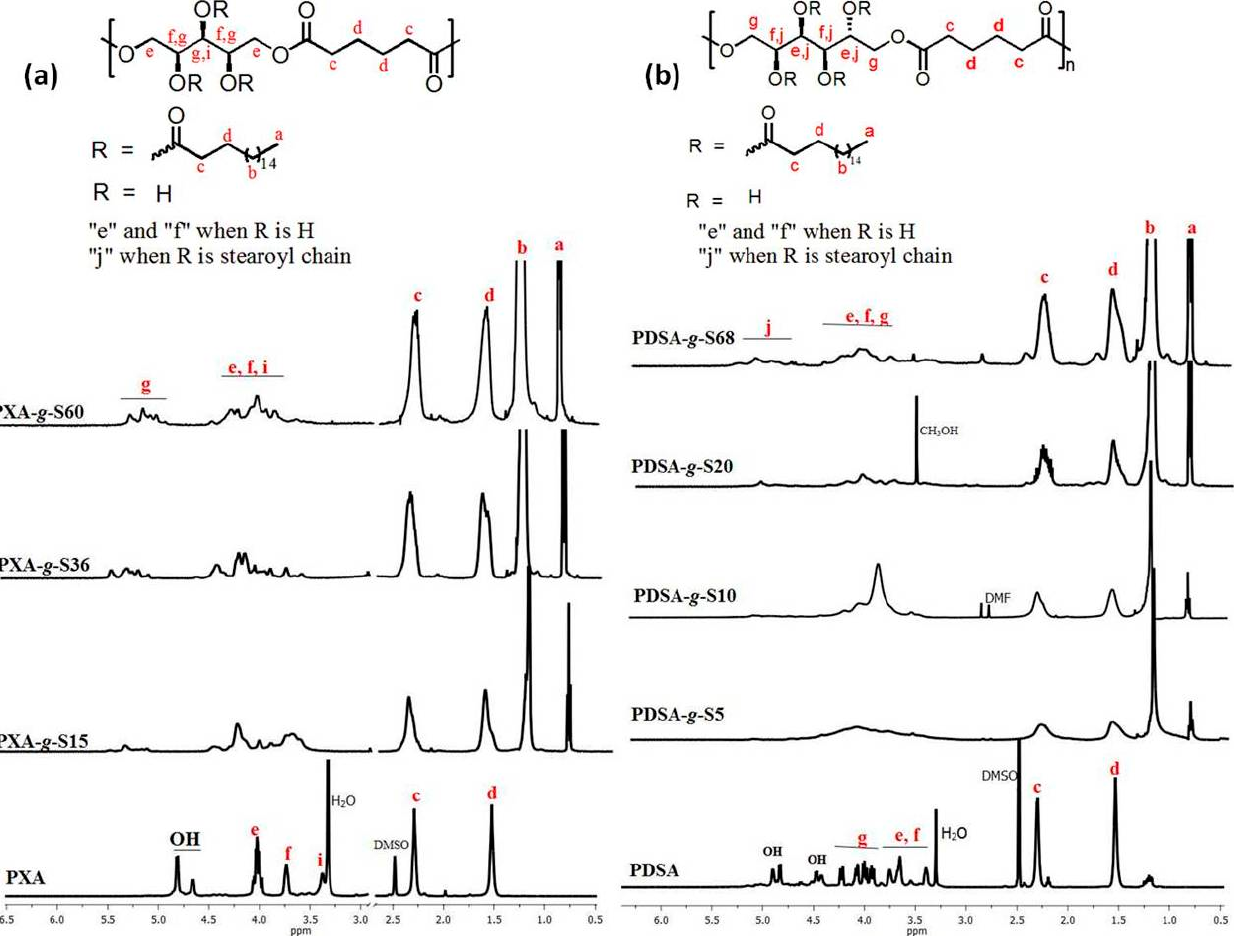
Figure 1. 1 H NMR spectra of ( a ) grafted and non-grafted poly(xylitol adipate) and ( b ) grafted and non-grafted poly( D -sorbitol adipate), recorded at 25 °C using CDCl 3 and DMSO-d 6 as solvent for grafted and non-grafted polymers, respectively.